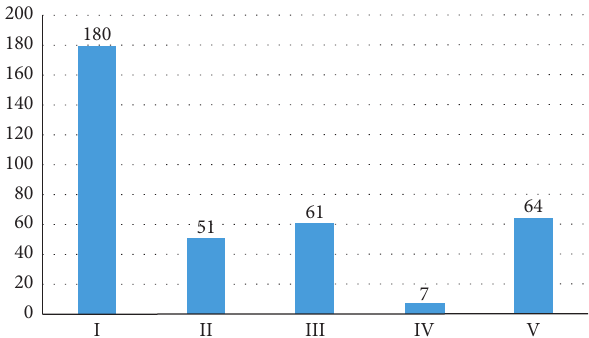
Figure 4: The number of national 5A tourist attractions with different comfort categories. I: “comfortable during spring and autumn”; II: “comfortable during spring, autumn, and winter”; III: “comfortable during spring, summer, and autumn”; IV: “un- comfortable during the four seasons”; and V: “comfortable during